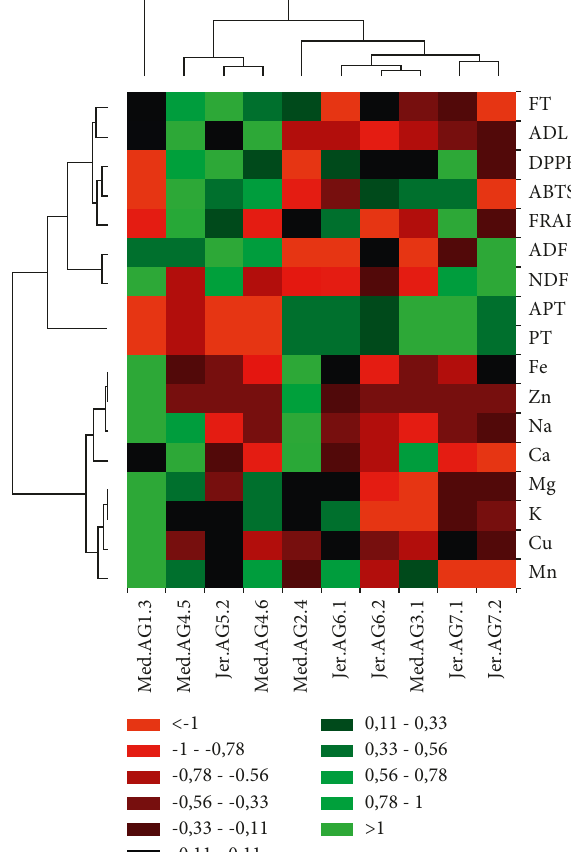
Figure 3: Heatmap and hierarchical clustering for phenolic contents, antioxidant activities, and chemical composition of pearl millet cultivars from southern Tunisia. Genotypes names are presented on the horizontal axis; green color presents the highest contents of minerals (Mn, Cu, K, Mg, Ca, Na, Zn, and Fe), total polyphenols (PT), total phenolic acids (APT), total flavonoids (FT), fibers (NDF, ADF, and ADL), and antioxidant activities (DPPH, ABTS, and